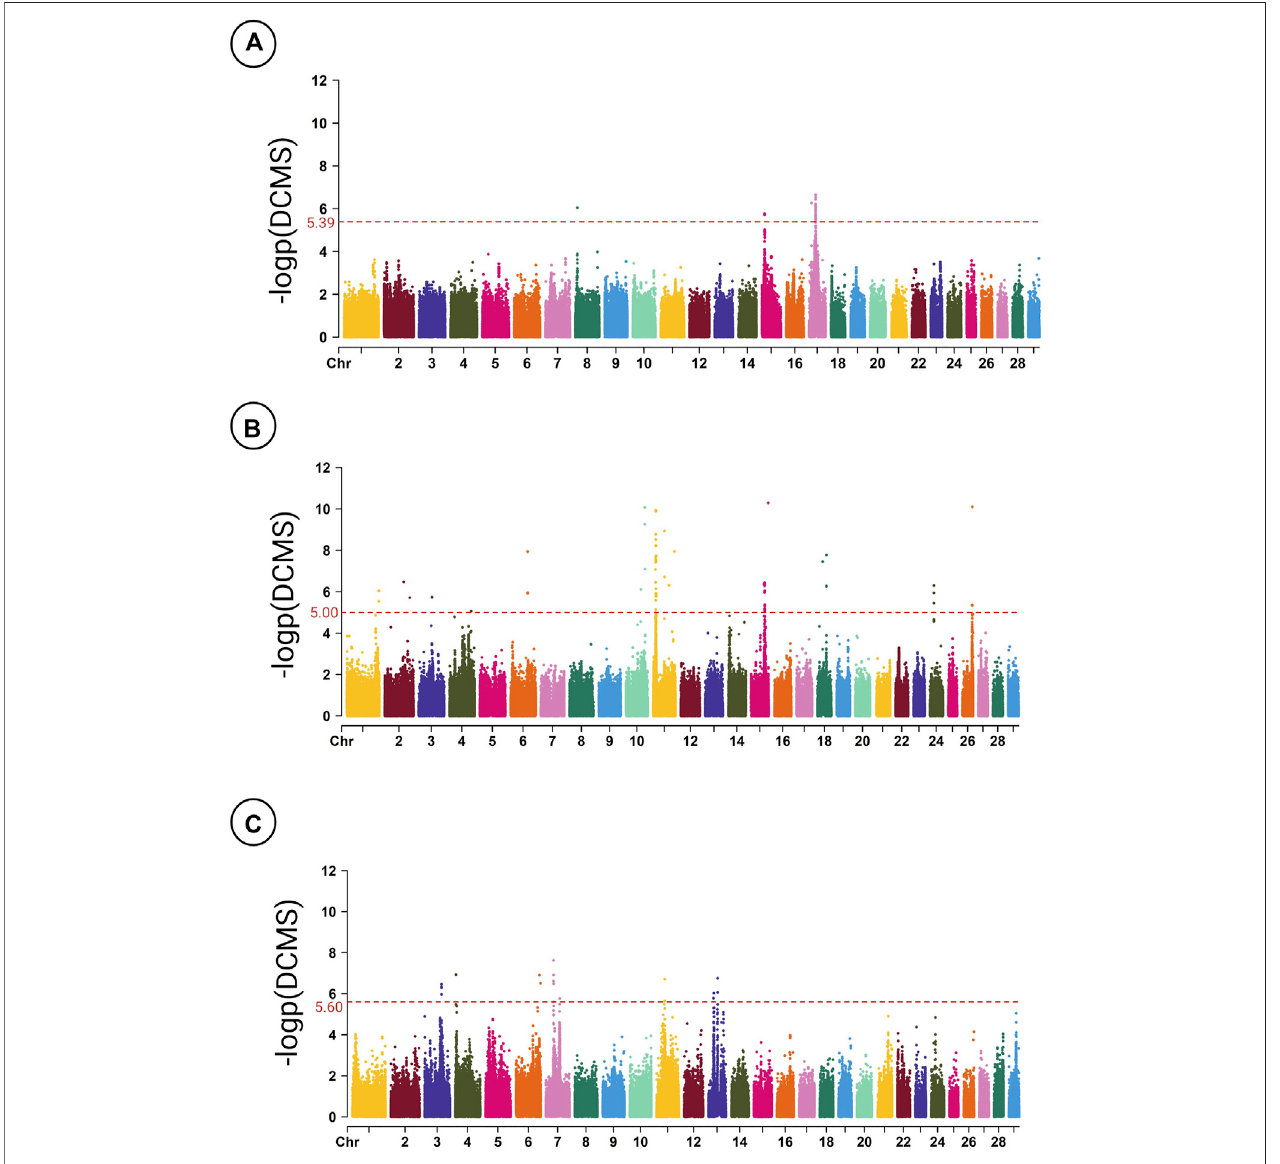
FIGURE 3 | Manhattan plot of the genomic regions under putative selection detected by DCMS in Beefmaster (A) , Brangus (B) , and Santa Gertrudis (C) . The dashed lines represent the signi fi cant threshold level at the FDR adjusted p -value < 5%.